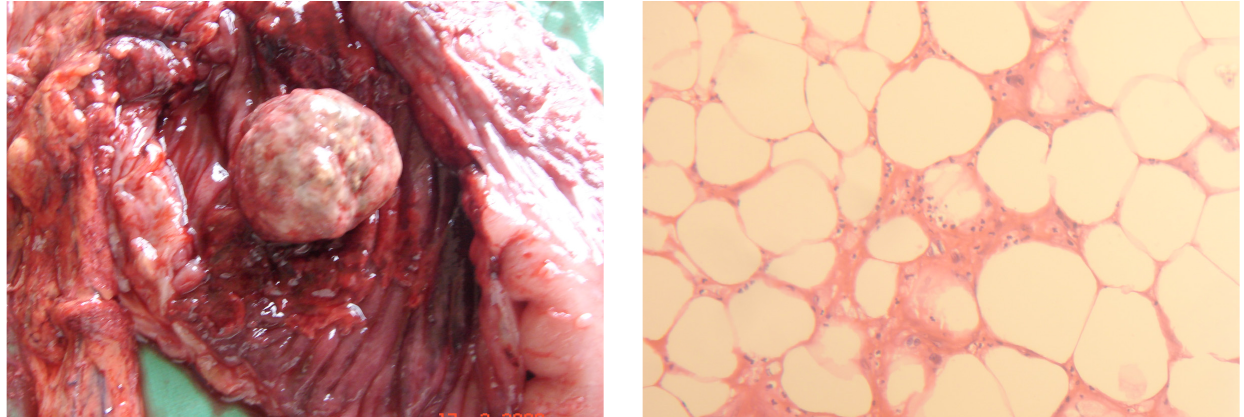
Figure 3A: A broad based colonic mass with ulcerative and fungating surface. B. Histopathology of the mass showing mature adipose tissue (HE stain, X100).